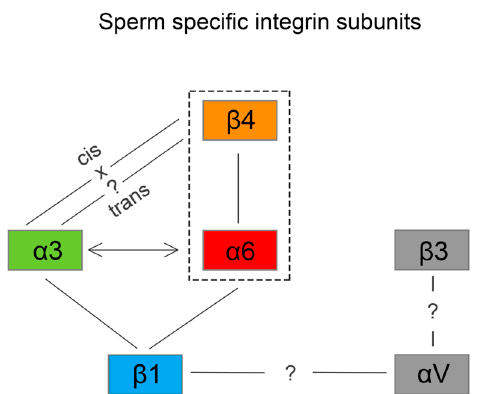
Figure 9. Diagram of sperm specific integrin subunits and heterodimers. The solid lines show proven integrin heterodimers α 3 β 1, α 6 β 1 and α 6 β 4; the arrows show predicted α 3 and α 6 dynamics with β 1; α 3 and β 4 cis interaction are energetically unstable in contract to trans interaction. Heterodimers between α V and β 1/ β 3 are not known.